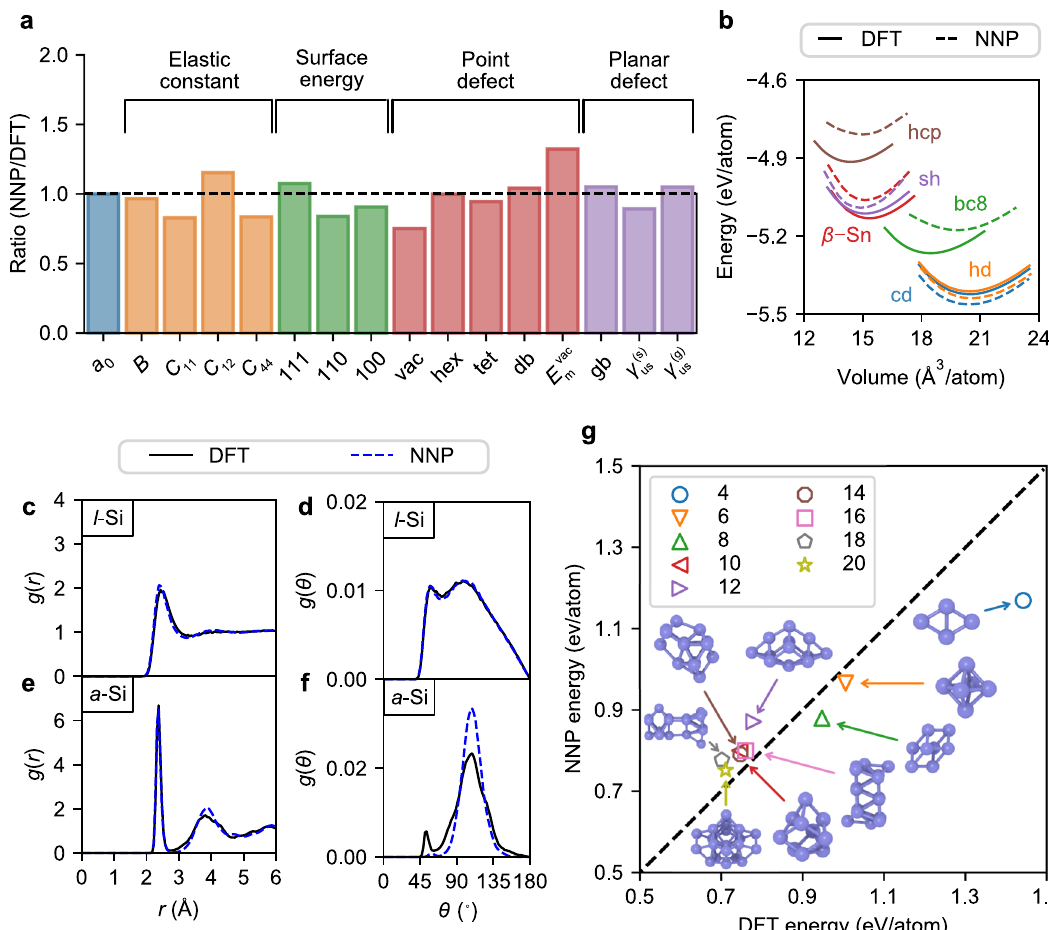
Fig. 5 Comparison between NNP and DFT results for various properties of Si. a Ratios of NNP to DFT for static properties of Si in the diamond structure. Surface energies are calculated for (100) – (2 × 2) 63 , (110) – (1 × 1) 64 , and (111) – (3 × 3) reconstructions 65 . Defect formation energies for the vacancy (vac) and interstitials (hexagonal (hex), tetrahedral (tet), and dumbbell (db)). E vac vacancy. For extended defects, gb means (112) Σ 3 grain boundary. γ ð s Þ us and γ ð g Þ us are unstable stacking-fault energies on shuf fl e and glide planes of the diamond (111) plane, respectively. b Equation of states for polymorphs. The abbreviations cd, hd, bc8, and sh stand for cubic diamond, hexagonal diamond, body-centered cubic, and simple hexagonal, respectively. c RDF and d angular distribution function (ADF; g ( θ ) of liquid Si ( l -Si) at 2500 K. e RDF and f ADF of amorphous Si ( a -Si) at 300 K. In b – f solid and dashed lines indicate the reference DFT and NNP results, respectively. g Energies of even-number nanoclusters in reference to the equilibrium diamond structure obtained by each method. Insets are structures relaxed by the